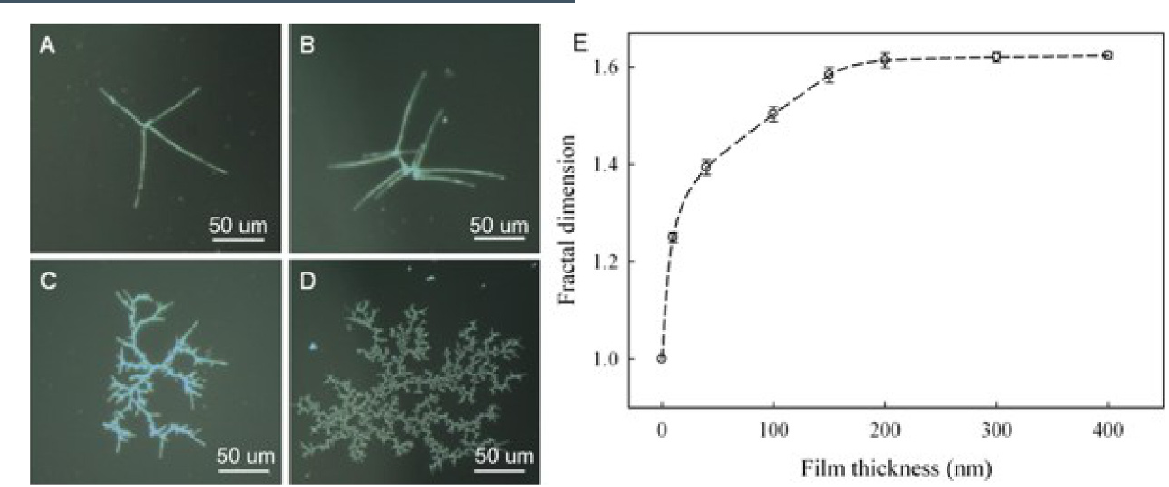
Figure 5. PETN films deposited on Si substrate with different thicknesses: A) 10 nm, B) 50 nm, C) 150 nm and D) 300 nm. E) Fractal dimension as a function of film